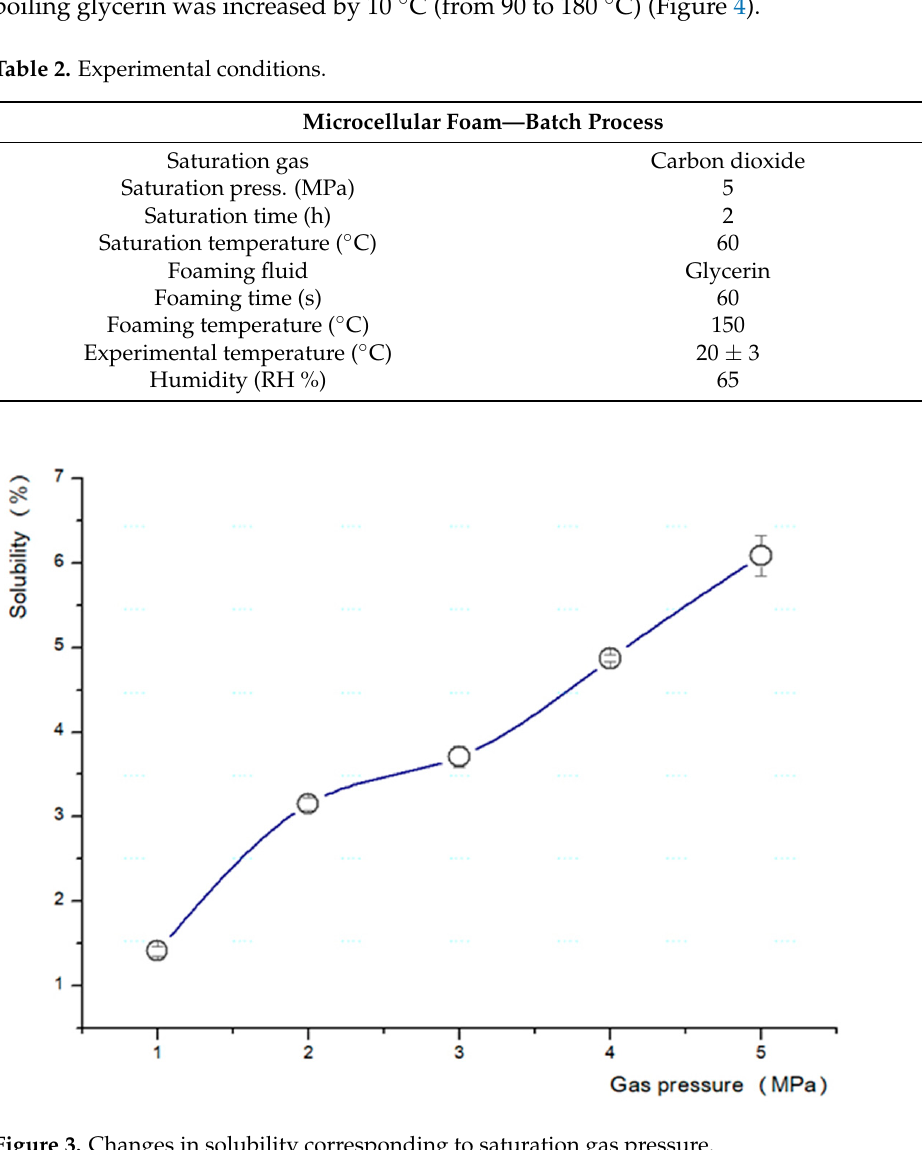
Figure 3. Changes in solubility corresponding to saturation gas pressure.